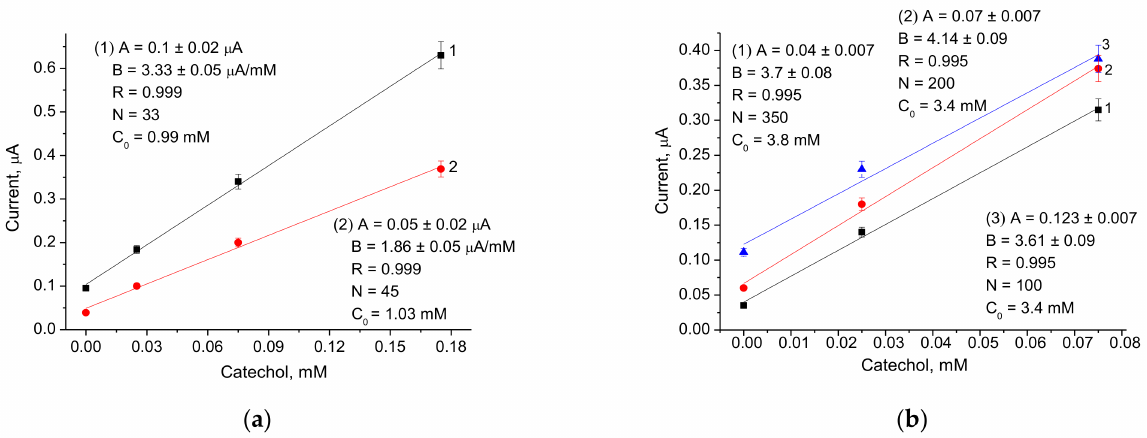
Figure 6. Assay of catechol using the laccase/CuCo-based ABS in the samples of wastewater supplemented with 1 mM catechol ( a ) and extract of green tea ( b